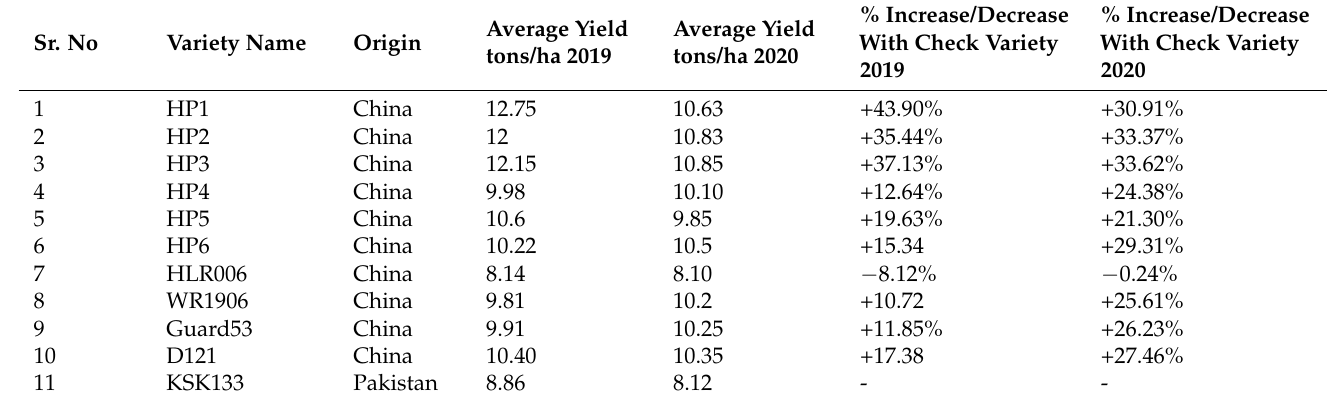
Table 2. Yield comparison of hybrid rice varieties with check